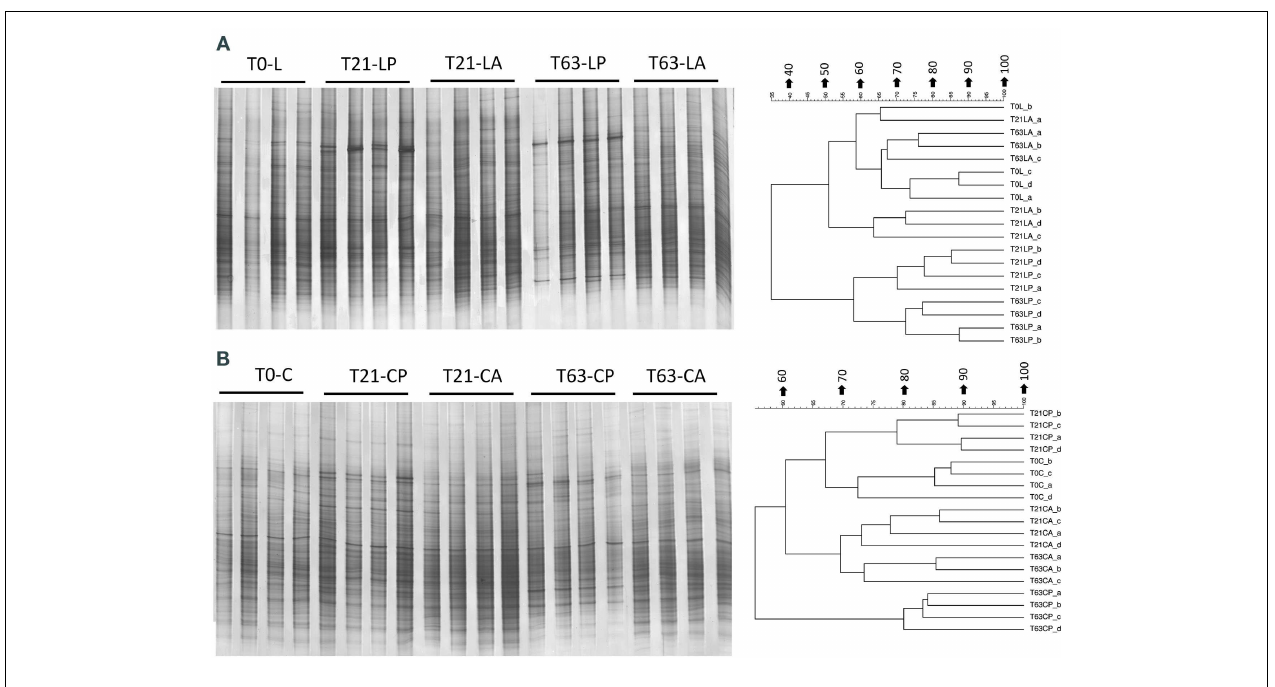
phenanthrene-spiked Cambisol) or not (LA: Luvisol control, CA: Cambisol control) on day 21 (T21) and 63 (T63) and the initial soils (L: Luvisol and C: Cambisol) on day 0 (T0).